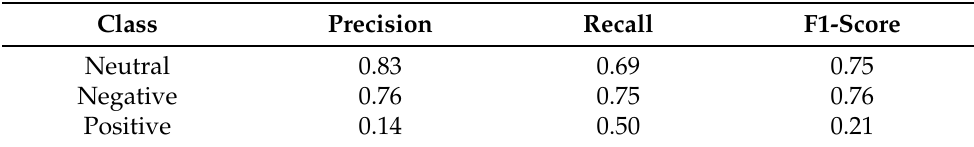
Table A1. Naïve Bayes